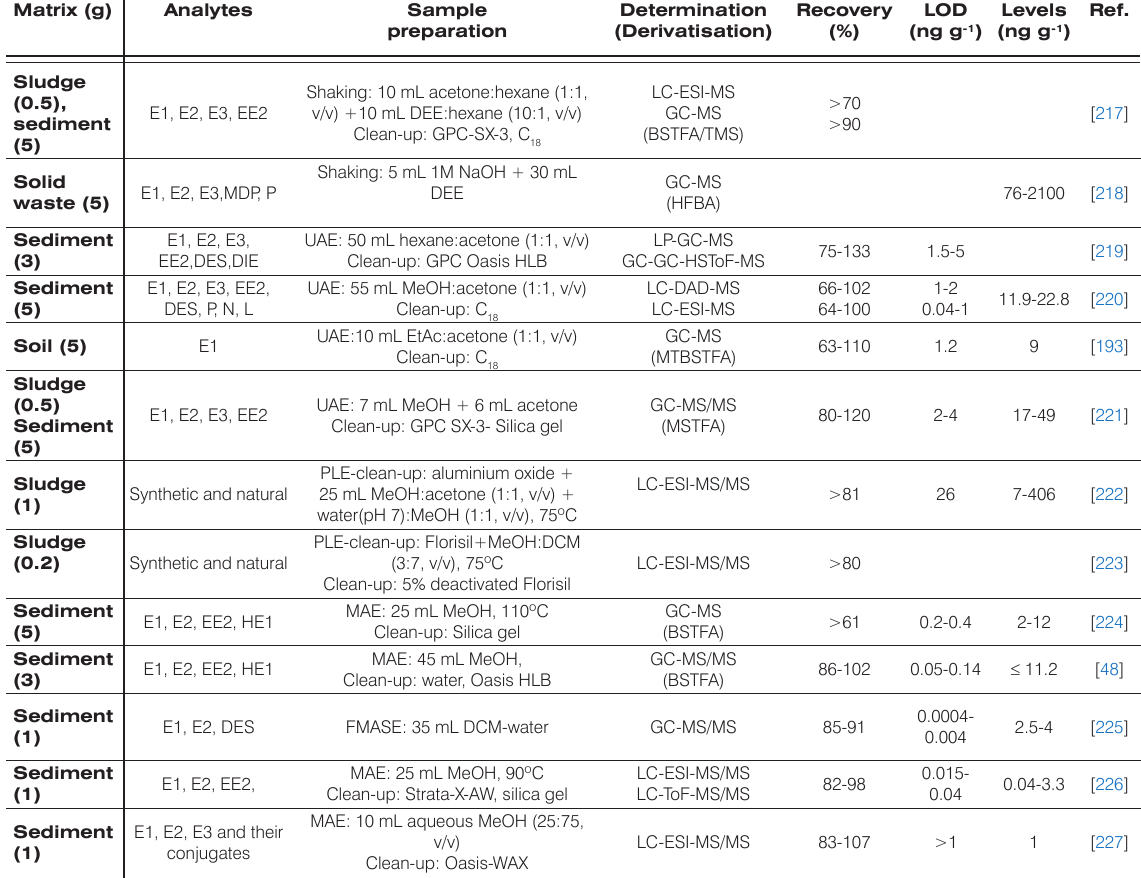
Table 9. Analysis of estrogens in environmental solid